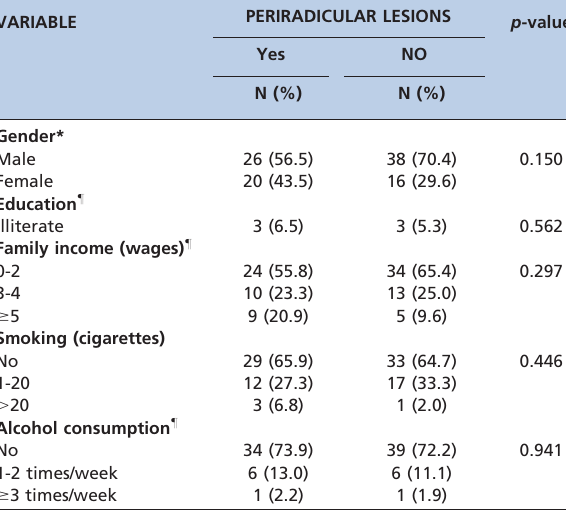
Table 1 - Bivariate analysis between periradicular lesions and the socio-demographic/health-related characteristics of the study population.